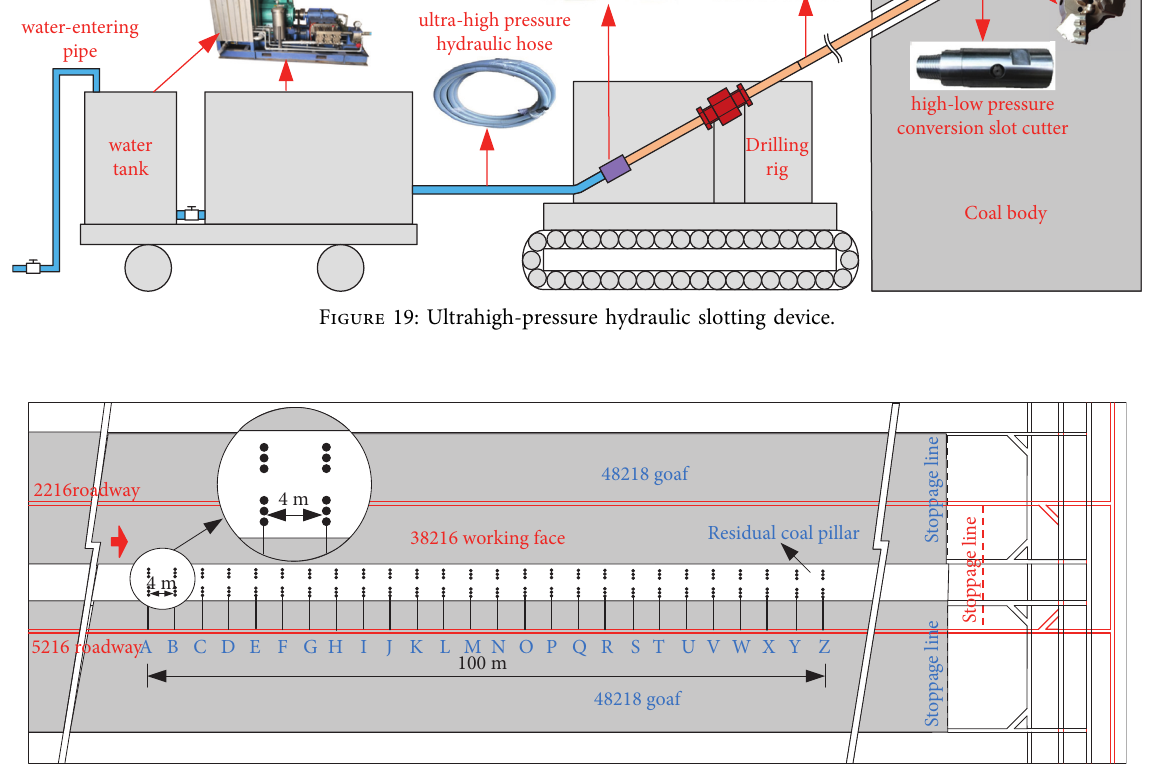
Figure 20: Layout of boreholes along the length of the residual coal pillar.